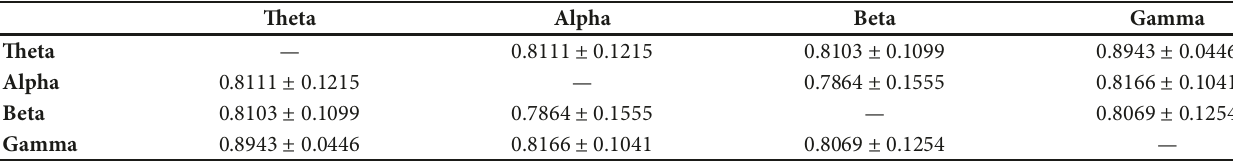
Figure 5: Analysis of the hospital contact networks. (Left) evolution of the structure of changes; note that the represented values correspond to 𝐼𝐶 ∗ . (Centre) hourly evolution of the link density through the data set. (Right) evolution of the structure as yielded by the normalised global overlap 𝑂 . Table 1: Average and standard deviation of the 𝐼𝐶 ∗ for the ten considered people, when networks of different frequency bands are pairwise